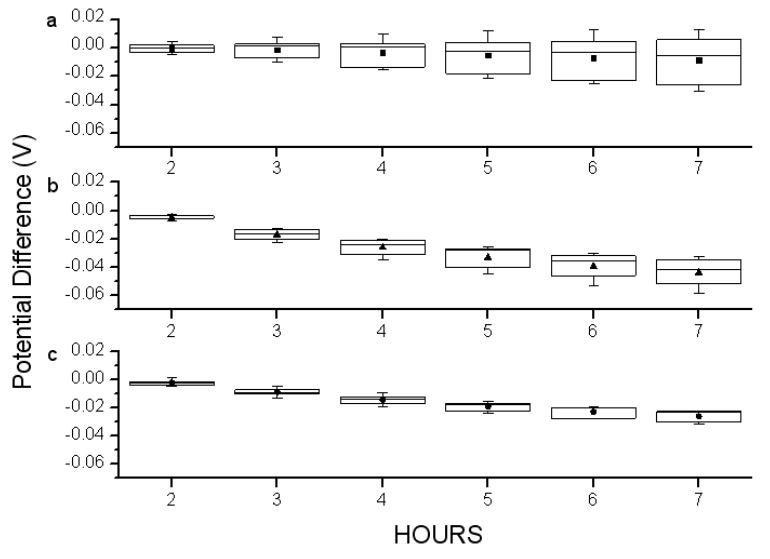
Figure 9. The charts of variations of the drift measured at different pH values from the second to seventh hour for (a) p-channel (b) n-channel ISFETs and (c) the compensation method. The box charts were calculated with the data measured from pH 3–pH 11 at different